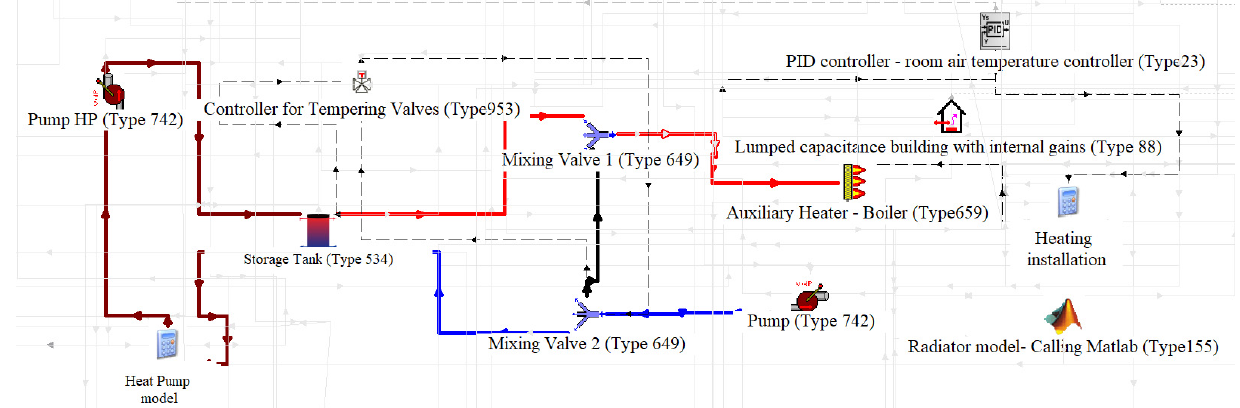
Figure 4. Main components of the heating system and building model in TRNSYS 17 [51] (part of the program code).